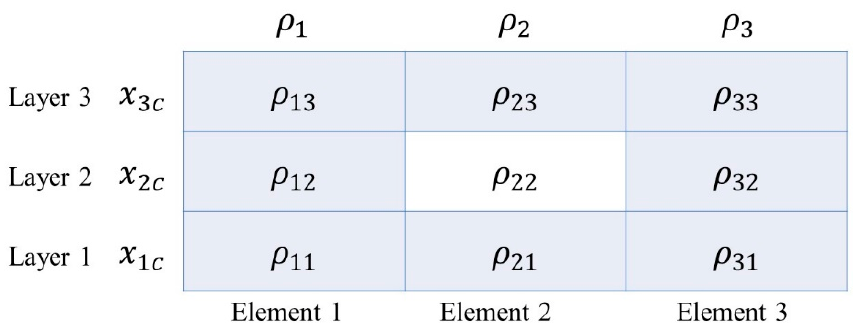
Figure 1. A three-layer laminate with the thickness topology variable ρ el , through-the-thickness variable ρ e and ply orientation variable x lc